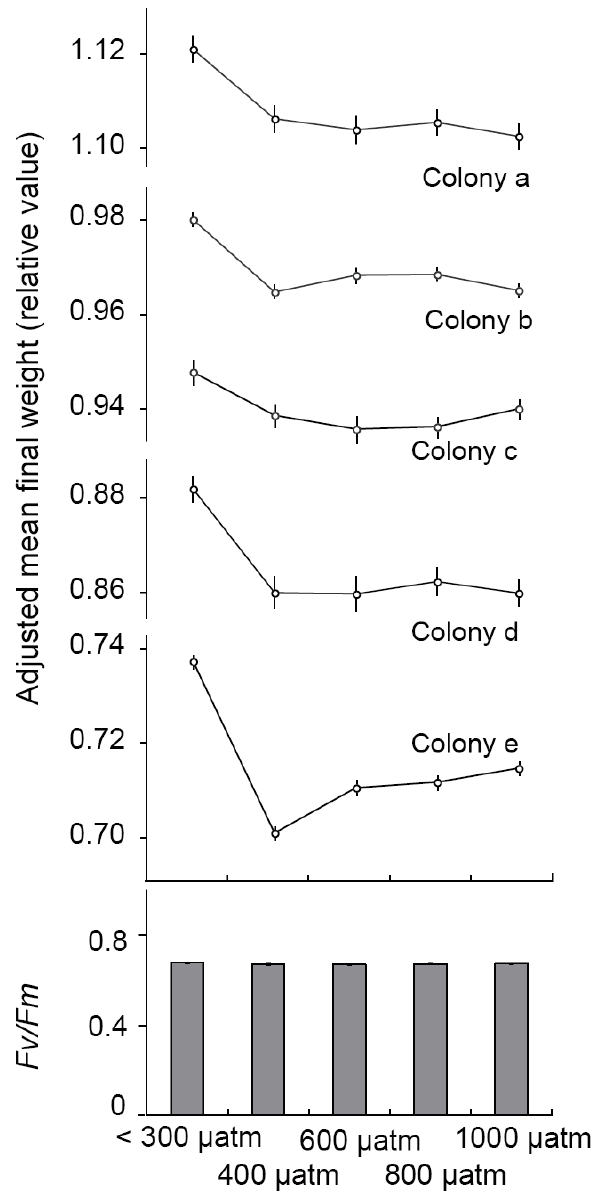
Fig. 2. Adjusted mean final weights of coral fragments and mean Fv/Fm values from five colonies (Colonies a–e) of Acropora digitifera in the five p CO 2 treatments: (i) pre-industrial p CO 2 , <300µatm, (ii) present-day p CO 2 at 400µatm, and at three near- future conditions, (iii) 600µatm, (iv) 800µatm, and (v) 1000µatm. Bars show